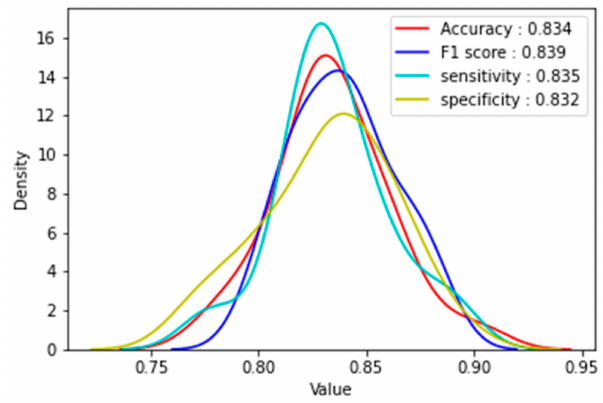
Figure 1. Performance of the Random Forest Model.